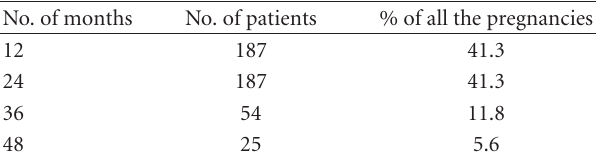
Table 1: Time from the first evaluation to the conception.